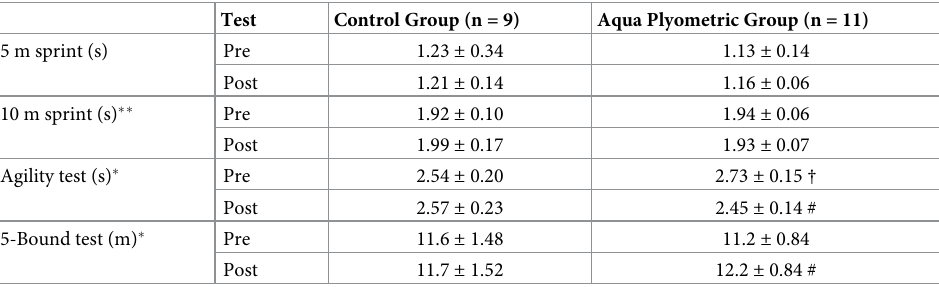
Table 3. Mean ± standard deviation for physical performance